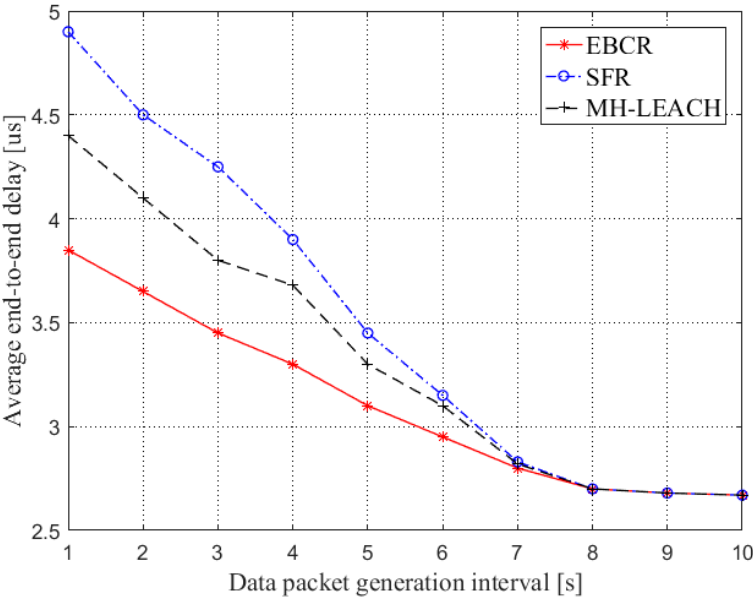
Figure 15. Comparison of average end-to-end delay.